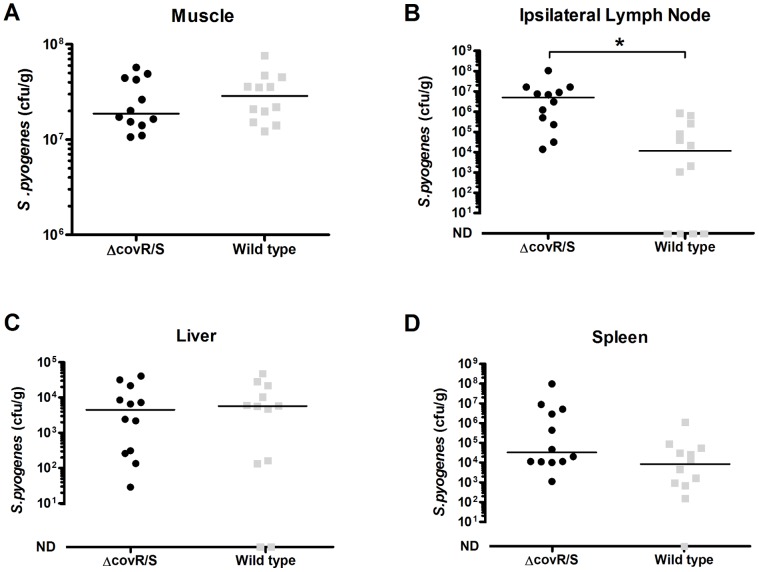
The effects of covR/S mutation on dissemination from an invasive intramuscular infection.Five week old FVB/n female mice (n = 12) were infected intramuscularly in the right thigh with either wild type S. pyogenes or an isogenic ΔcovR/S strain (6×108 cfu per dose). After three days there was no significant difference in bacterial growth within the thigh (A, Mann Whitney U p>0.05), but there was a significant difference in bacterial numbers that had disseminated to the inguinal node (B, Mann Whitney U p<0.05). No significant difference in dissemination to the liver (C) and the spleen (D) was found between the wild type and the ΔcovR/S strains. Median indicated by a black line.